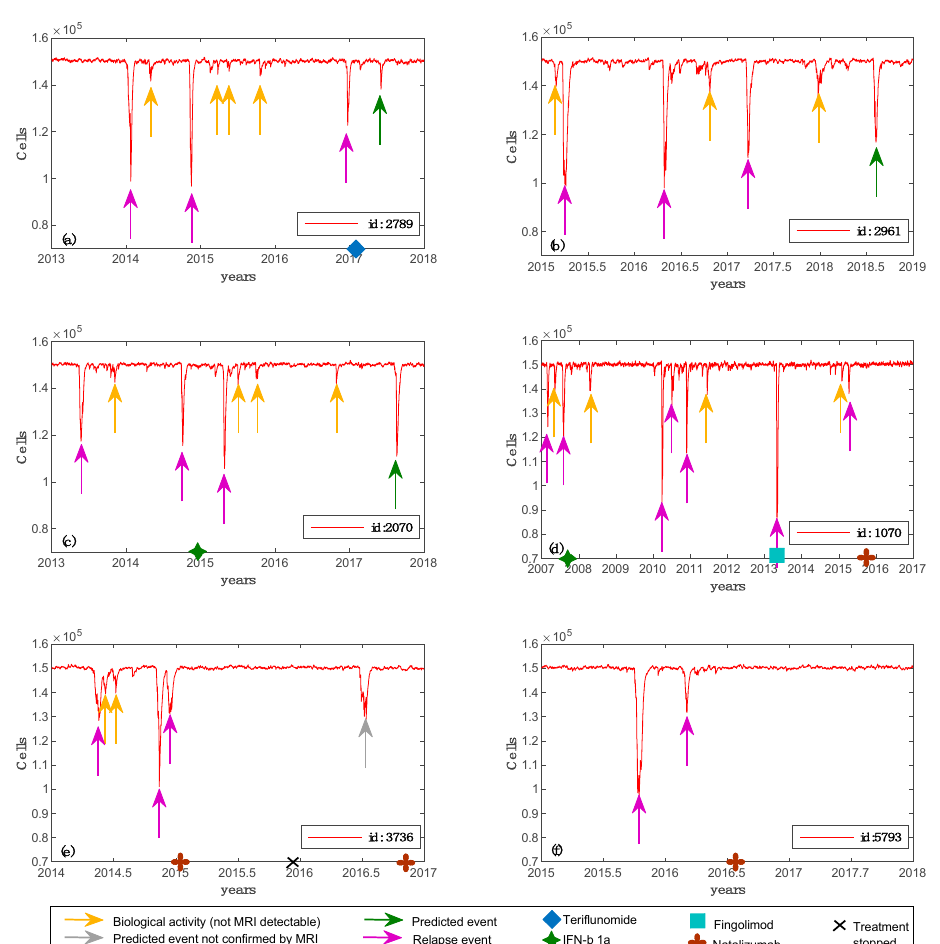
Figure 3. Simulated oligodendrocyte (ODC) dynamics for six patients. For each of the six patients, we depict the best simulation obtained, i.e., the one that parallels real patient data. Specifically, in panel ( a ), virtual patient id 2789 has an age belonging to the range 30–39; MS was initially diagnosed at the age of 33; oligoclonal bands are positive; the patient was two times pregnant; the maximum number of lesions detected by Magnetic Resonance Imaging (MRI) scan was 14; spinal lesions were not detected and teriflunomide was the chosen treatment. In panel ( b ), virtual patient id 2961 has an age belonging to the range 30–39; MS was initially diagnosed at the age of 29; oligoclonal bands are negative; no pregnancy was detected; the maximum number of lesions detected by MRI scan was 65; spinal lesions were not detected and no treatment was chosen. In panel ( c ), virtual patient id 2070 has an age belonging to the range 30–39; MS was initially diagnosed at the age of 31; oligoclonal bands are negative; no pregnancy was detected; the maximum number of lesions detected by MRI scan was 49; spinal lesions were not detected and IFN- β 1a was the chosen treatment. In panel ( d ), virtual patient id 1070 has an age belonging to the range 20–29; MS was initially diagnosed at the age of 20; oligoclonal bands are positive; no pregnancy was detected; the maximum number of lesions detected by MRI scan was 82; spinal lesions were detected by MRI scan and IFN-b 1a was the first chosen treatment, then fingolimod and finally natalizumab were administered. In panel ( e ), virtual patient id 3736 has an age belonging to the range 30–39; MS was initially diagnosed at the age of 30; oligoclonal bands are positive; the patient was one time pregnant; the maximum number of lesions detected by MRI scan was 28; spinal lesions were not detected by MRI scan and natalizumab was the chosen treatment. In panel ( f ), virtual patient id 5793 has an age belonging to the range 20–29; MS was initially diagnosed at the age of 26; oligoclonal bands are positive; no pregnancy was detected; the maximum number of lesions detected by MRI scan was 28; spinal lesions were not detected by MRI scan and natalizumab was the chosen